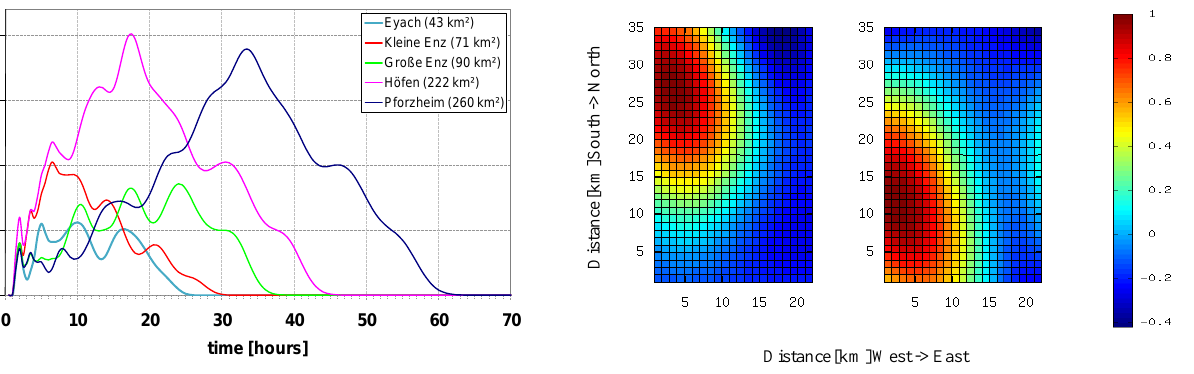
Fig. 5. The initial soil moisture of the CONTROL simulation is per- turbed applying the 2-D-pseudorandom sampling method and algo- rithm (http://enkf.nersc.no) of Evensen (2004) to obtain 100 ensem- ble members of initial soil moisture fields. The 2-D-pseudorandom fields vary up to d =± 1 and examples are shown for 2 ensemble